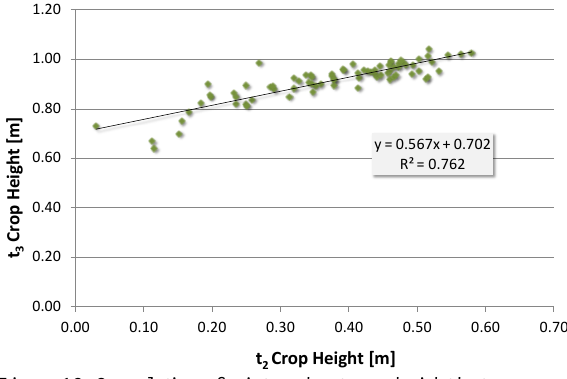
Figure 13. Correlation of winter wheat crop height between epoch 2 (24.May) and epoch 3 (02. July) For modern wheat varieties, which are also kept artificially short using growth regulators, the plant height differences are less at the end of the growing season than during the main growth phase. Only a few cm separate high cereal crops from small crops. This means a reliable correlation between yield and crop height requires very accurate height information. This holds true not only for the DEM but also for the reference DTM. The yield significantly differs in the field trial. Plots with similar nutrient dressings are distributed over the whole field. Similar plots were summarized in order to compensate for any local inaccuracies in the height measurement. Nevertheless, the relationship between yield and the plant height is not as clear as expected, or described in the literature e.g. Girma et al, 2006, see figure. 14.